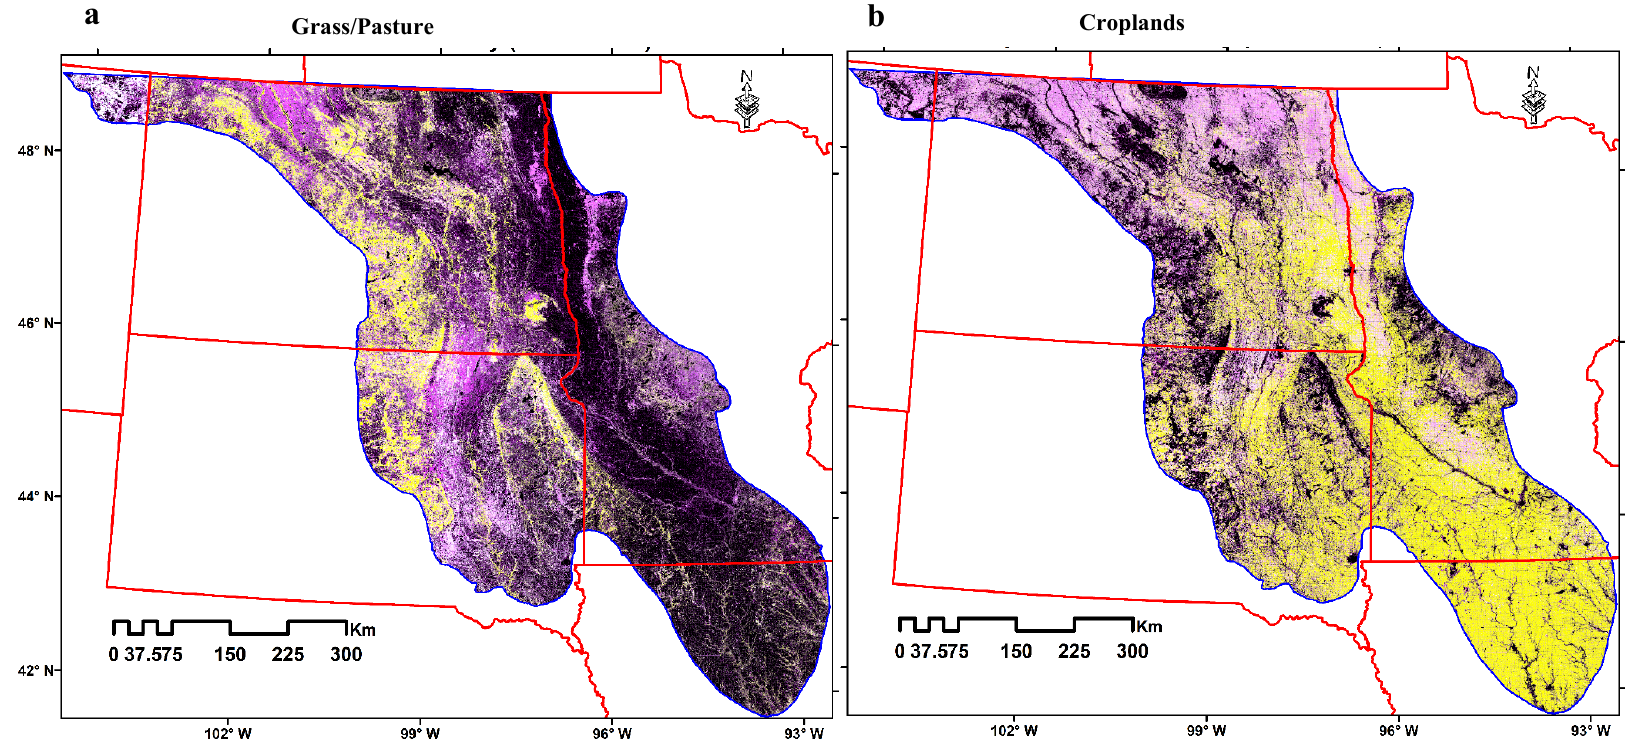
Figure 8. Grass / pasture and crop covers persistency map is a false color composite of CDL time series where: Red color plane was assigned to the maximum percentage of cover, Green to the average percentage of cover, Blue to the range of coverage (max %–min %). Interpretation: Yellow → stable core areas, White → unstable core areas, Magenta → unstable periphery, Black → cover does not occur. Note that grass / pasture are dominated by shades of magenta to purple indicating higher variation and low average. (cf. Table 1 for interpretative